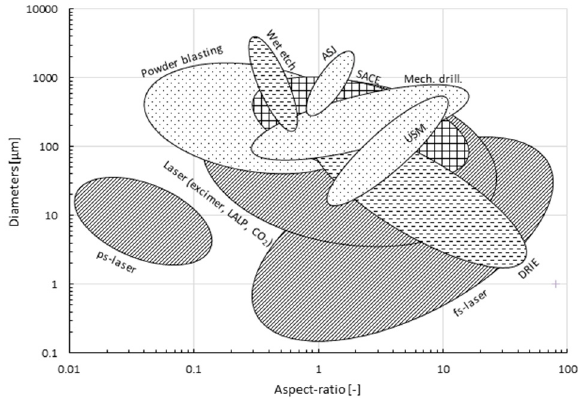
Figure 3. Machined diameters ( μ m) vs. aspect ratio ( µ m/ µ m) for different glass drilling methods, grouped into four categories (mechanical, thermal, chemical and hybrid). Values in graph based on Table A1.